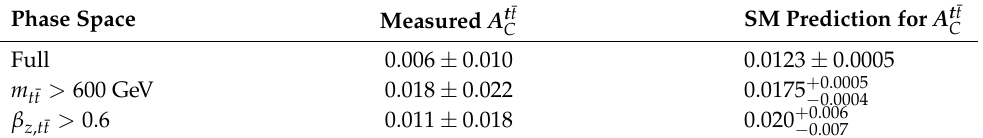
Table 3. Measured inclusive charge asymmetry values for the electron and muon channels combined after unfolding for the full phase space, for events with β z , t ¯ t > 0.6, and for events with m t ¯ t > 600 GeV [29], along with the respective predictions [14]. The uncertainties of the measurements include statistical and systematic components.